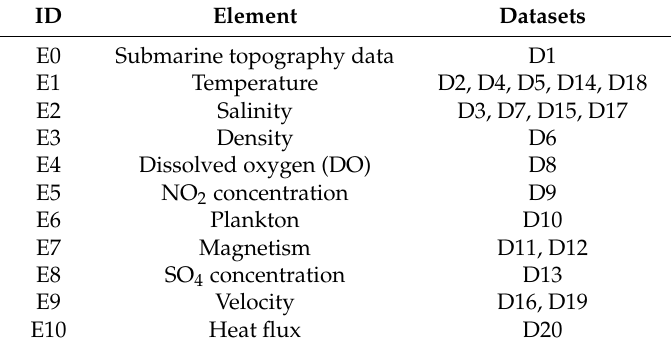
Table 1. Introduction of datasets.